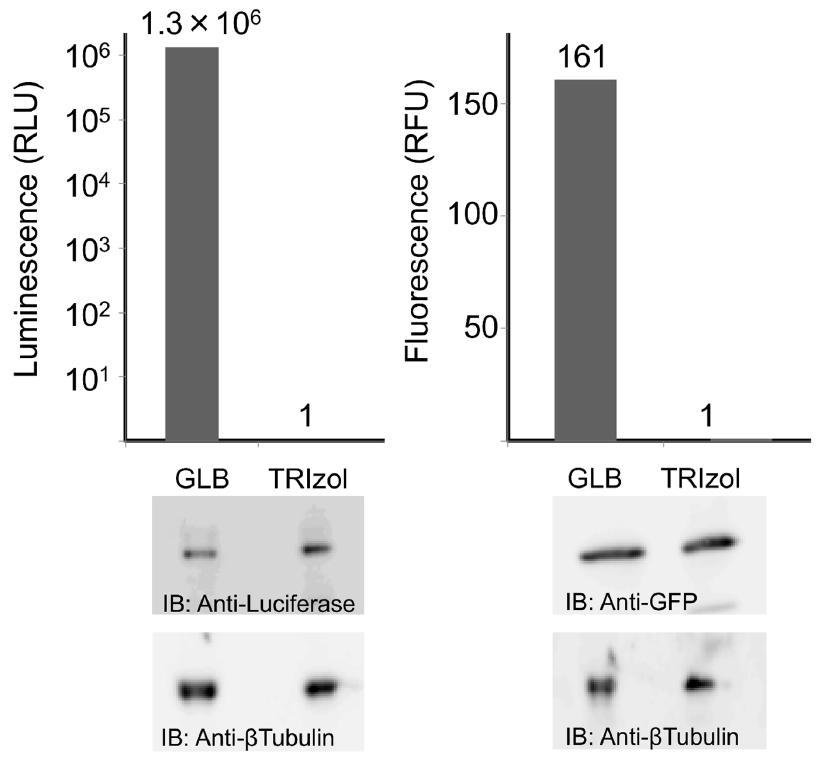
Figure 4. Biological activity of reporter proteins in physiological buffer or TRIzol lysates. Hek293 cells expressing either GFP or Luc were directly lysed in physiological Glo Lysis buffer (GLB) or TRIzol, and GFP or Luc activity were measured. Reporter proteins were verified by western blotting.